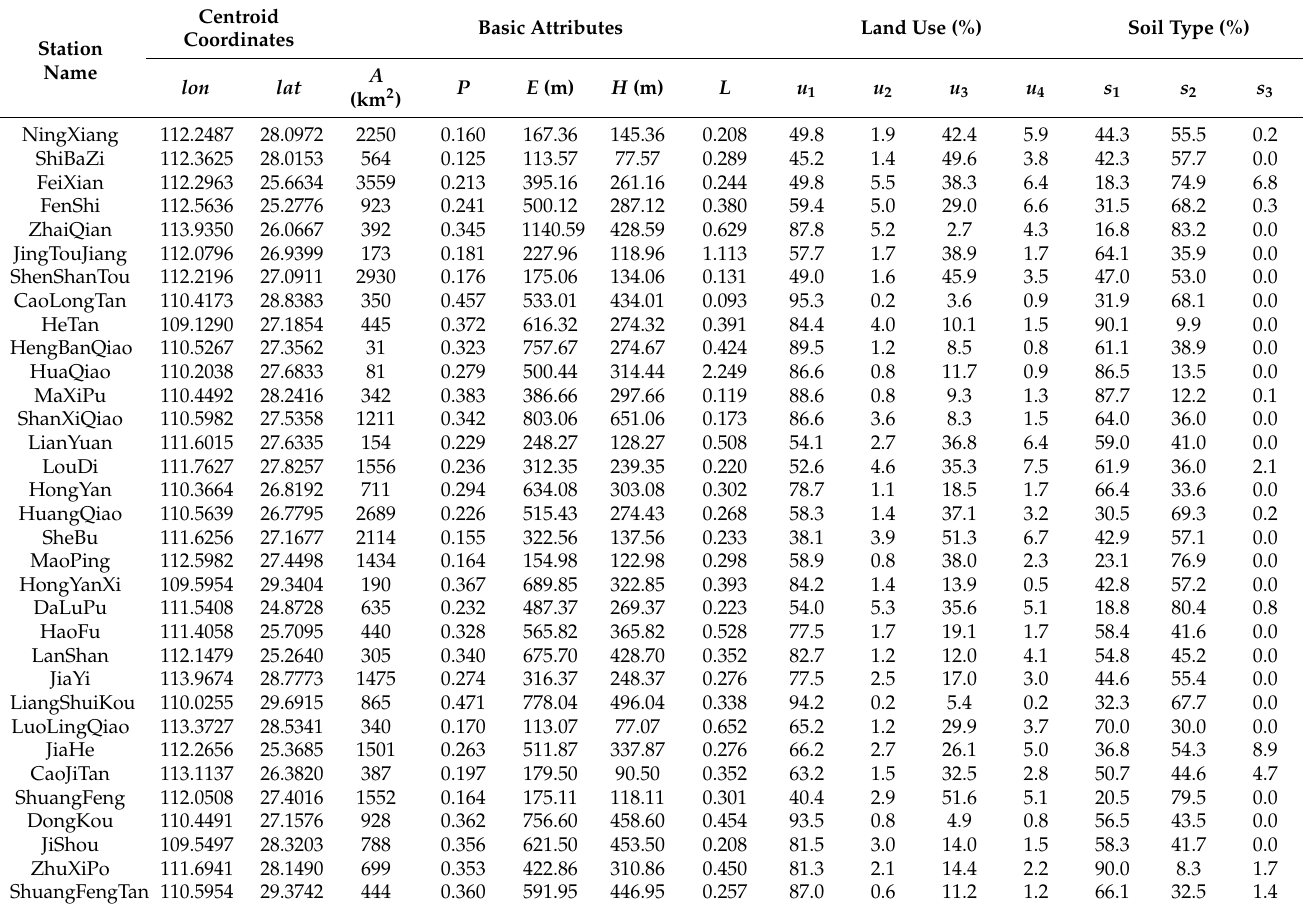
Table 5, including east longitude ( lon , ◦ ), north latitude ( lat , ◦ ), area ( A , km 2 ), average slope ( P ), average elevation ( E , m), average elevation drop ( H , m), shape coefficient ( L ), and the percentages of forest ( u 1 ), grass ( u 2 ), cultivated land ( u 3 ), other ( u 3 ), clay ( s 1 ), silt ( s 2 ) and sand ( s 3 ). These attributes were extracted during sub-watershed division. Table 5. Information of typical watershed